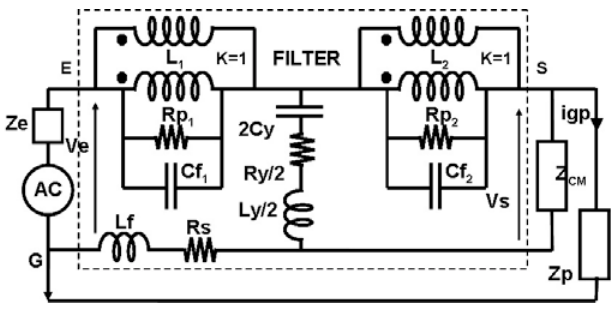
Figure 6: Determination of the common and differential attenuations of the filter. Figure 7: High frequency model of the CM filter